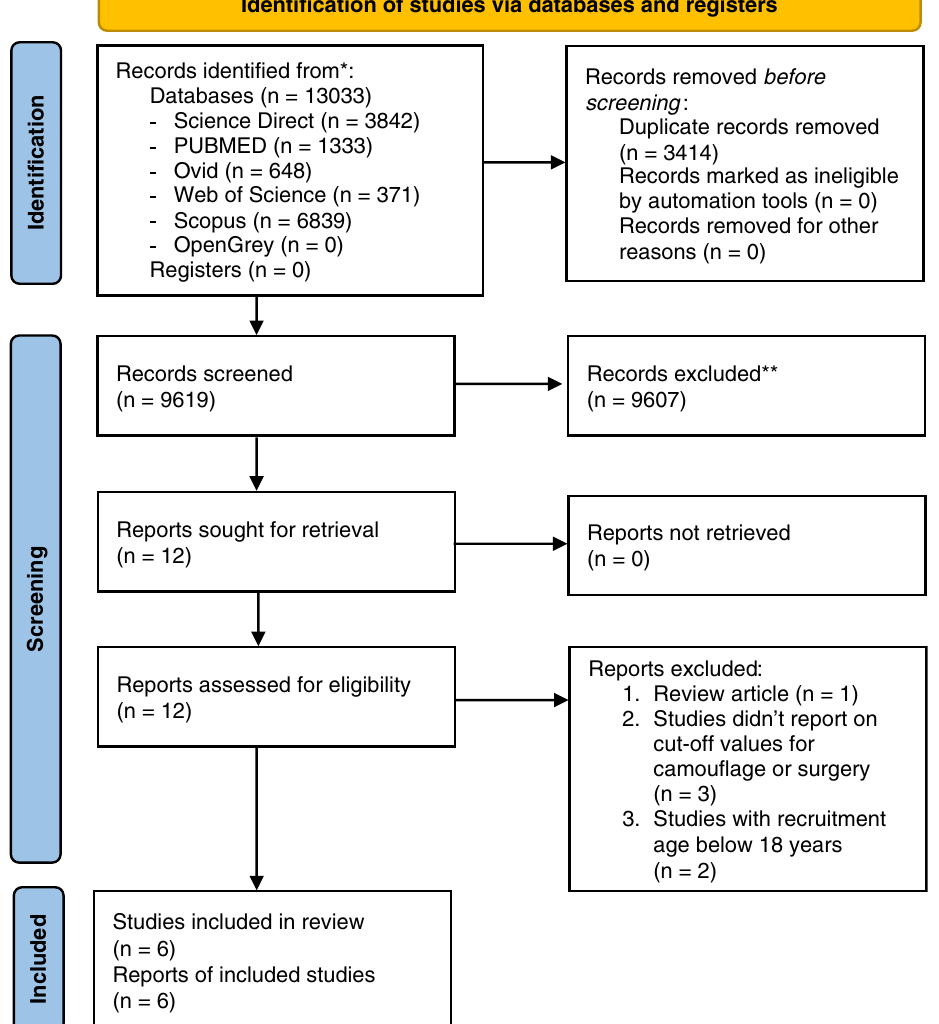
Figure 1. Preferred Reporting Items for Systematic Reviews and Meta-Analyses flow diagram of the included